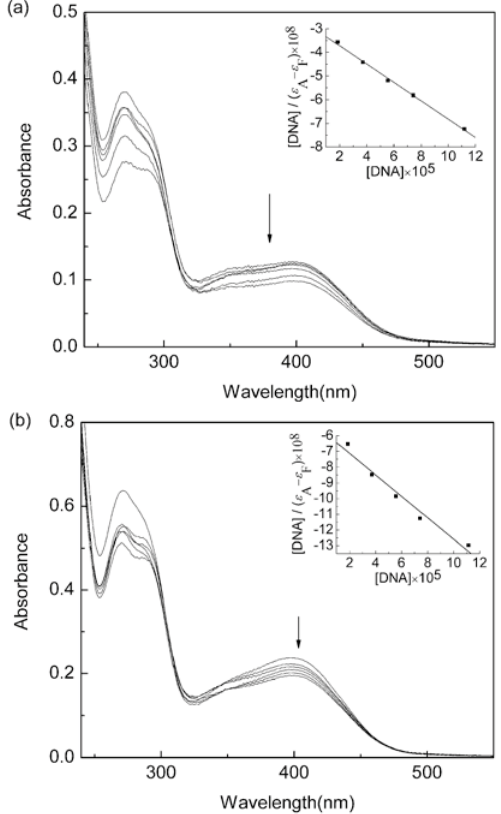
Figure 3. Absorption spectra of the La(III) complex (a) and Gd(III) complex (b) in Tris buffer in the presence of increasing amounts of CT-DNA. Arrows show the absorption changes upon increasing DNA concentration. Inserts: Plots of [DNA]/( ε - ε ) versus [DNA] with the standard deviations A F of 0.15, 0.20 and the linear correlation coefficients of 0.9961, 0.9905 for (a) and (b), respectively. In all cases: [Complex] = 50 μmol L -1 ; r([DNA]/[Complex])=0, 0.37, 0.74, 1.11, 1.48, 2.22,